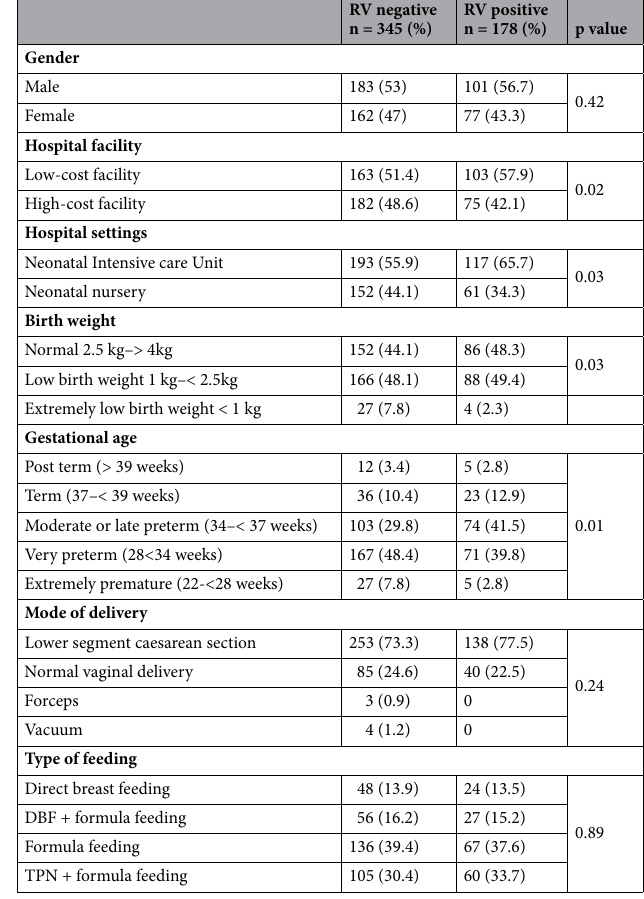
Table 2. Demographic profile and characteristics of study participants among RV positive and negative neonates. Pearson’s Chi Square ( χ 2 ):34.26, n = 523, α-0.05, one-tailed, Cumulative p-value: 0.034. TPN total parenteral nutrition, DBF direct breast